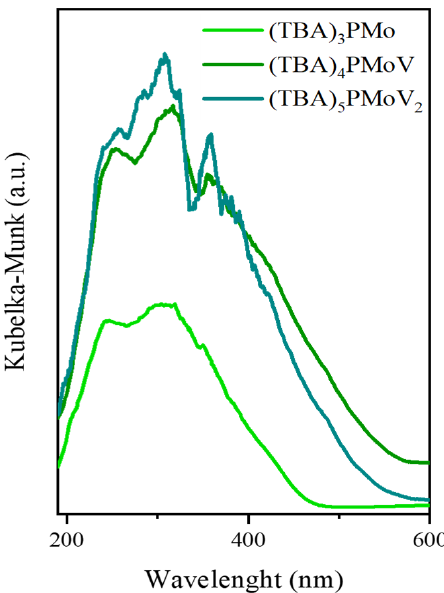
Figure 4. DRS UV-Vis spectra of pure and V-substituted Mo Keggin-type polyoxometalates.